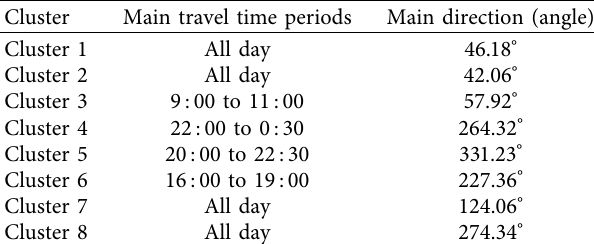
Table 4: Detailed information of each cluster on